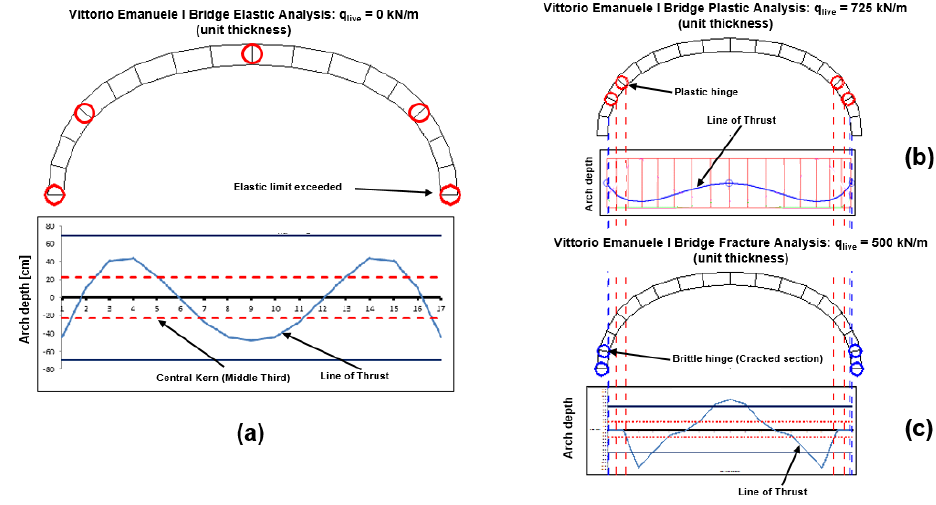
Figure 12. Vittorio Emanuele I bridge: ( a ) Elastic, ( b ) plastic, and ( c ) fracture analyses.